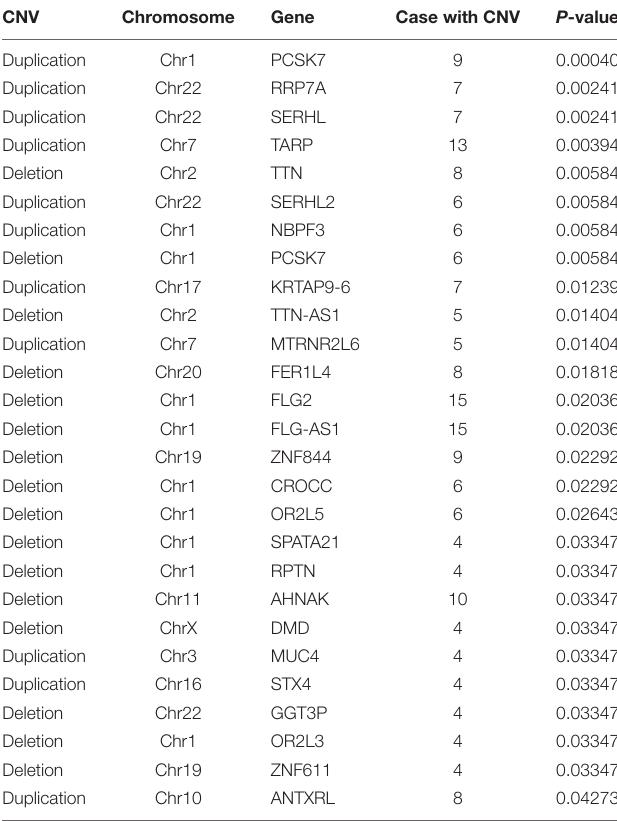
TABLE 2 | Copy number variant (CNV) detected by Fisher’ test.